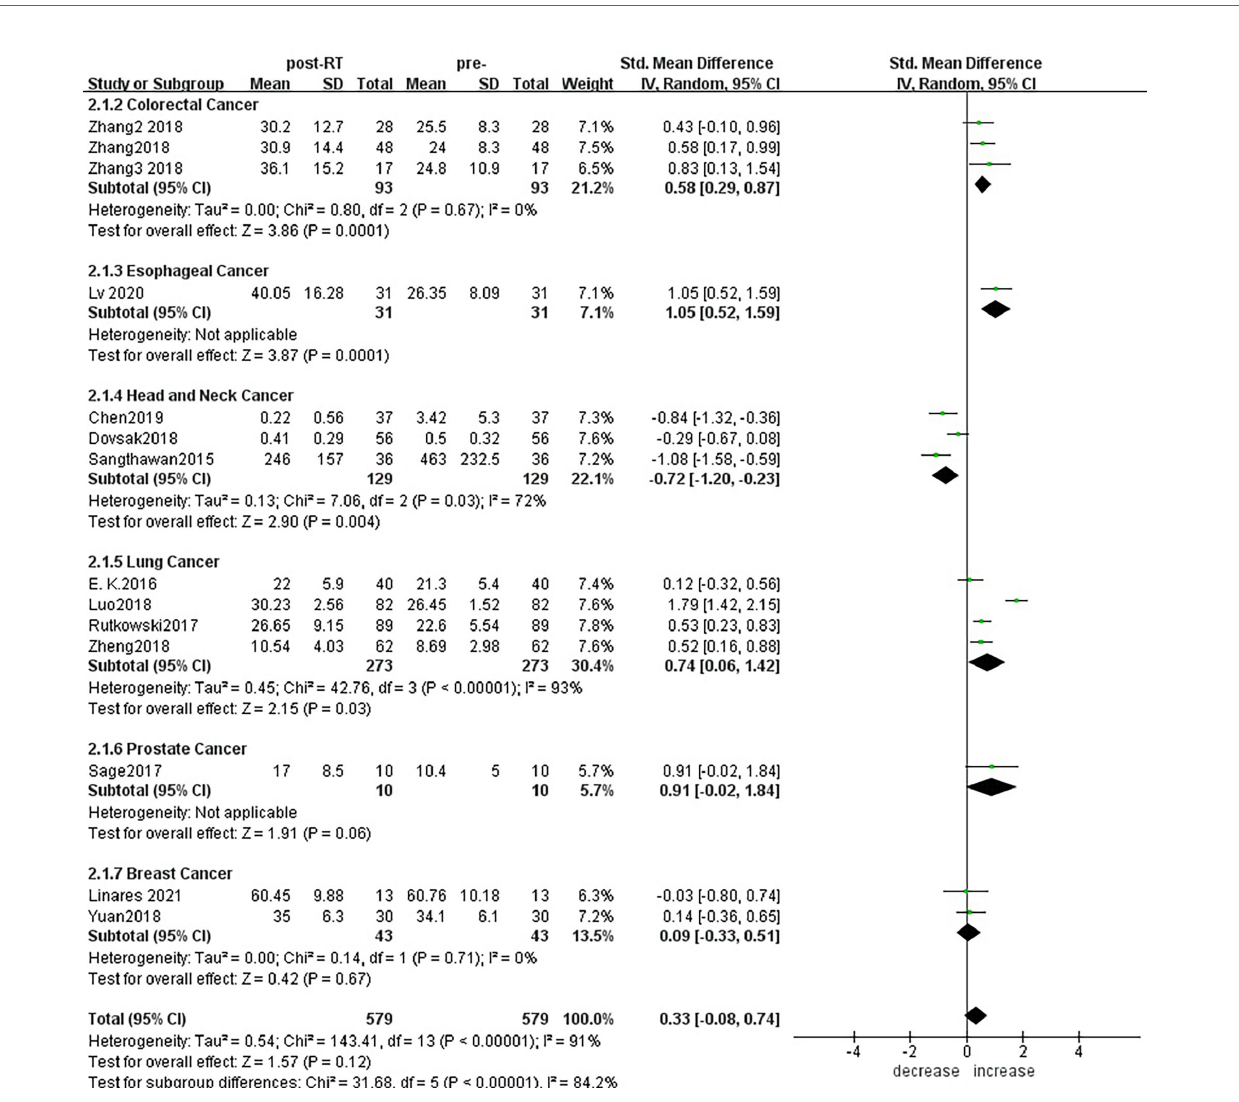
FIGURE 9 | Forest plots of subgroup analysis for changes of CD8+ T lymphocyte after radiotherapy compared with before radiotherapy in different